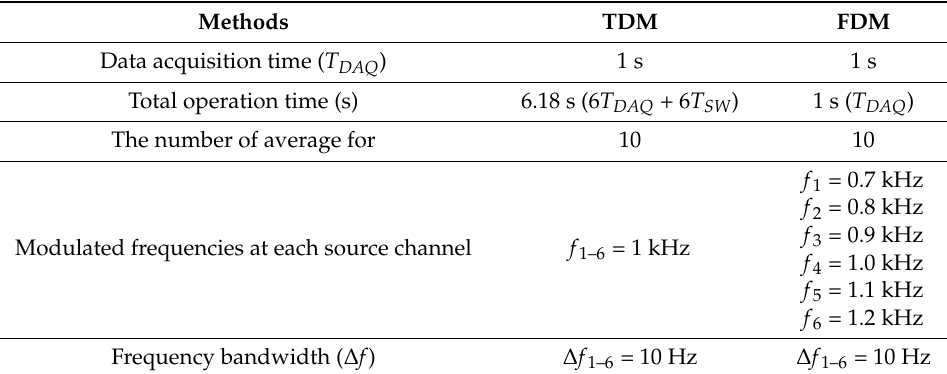
Table 1. Comparison between the TDM DOT and FDM DOT systems. “ T DAQ ” and “ T SW ” are acronyms for “data acquisition time” and “switching time”,